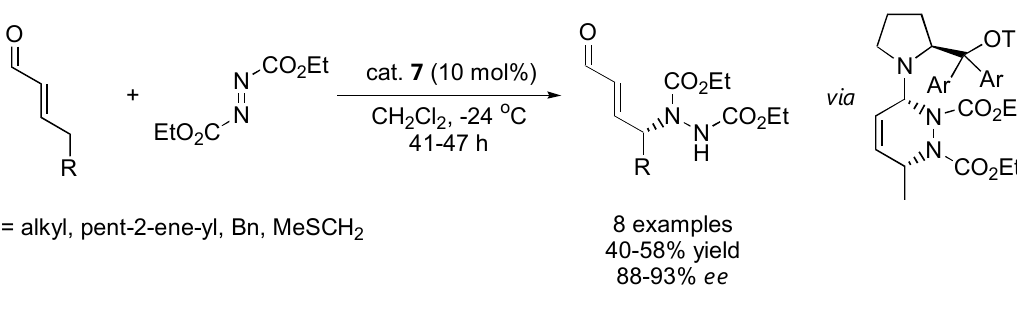
Figure 11. Direct  -amination of  ,  -unsaturated aldehydes catalyzed by 7